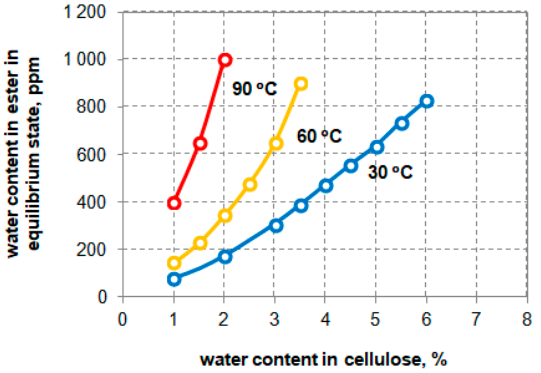
Figure 10. Moisture of the ester in the equilibrium state of the cellulose-ester system depending on the